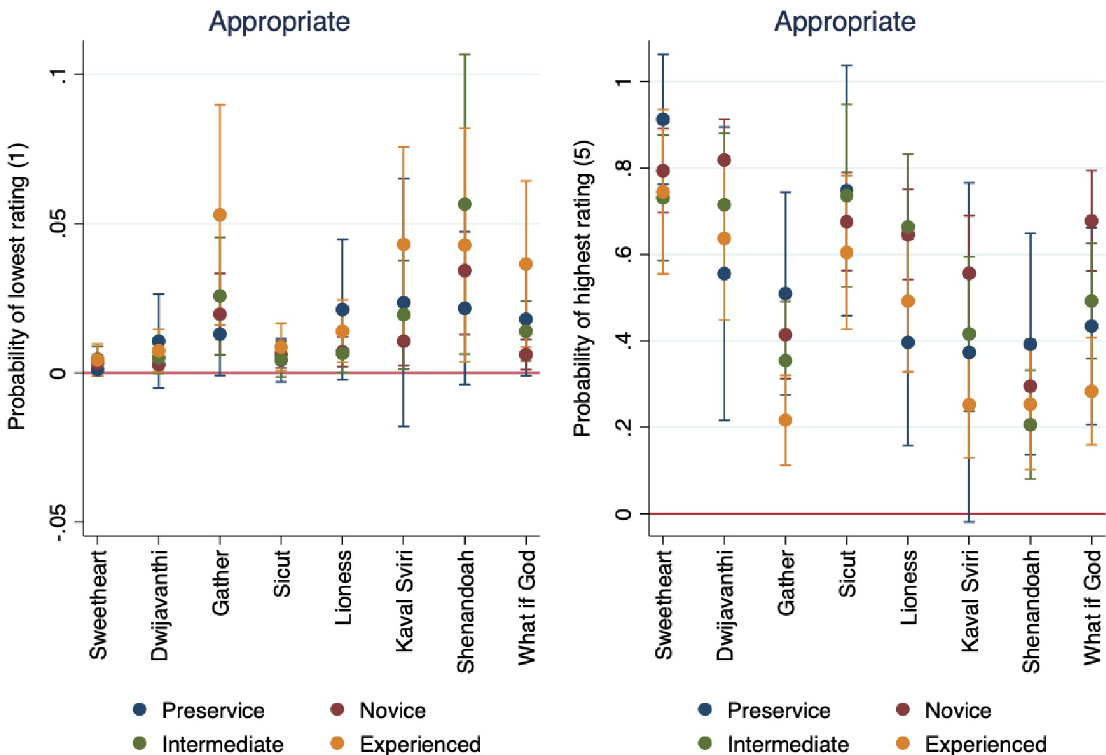
Fig 4. Marginal effects of years’ experience on probability of rating audio samples as appropriate, by audio sample.